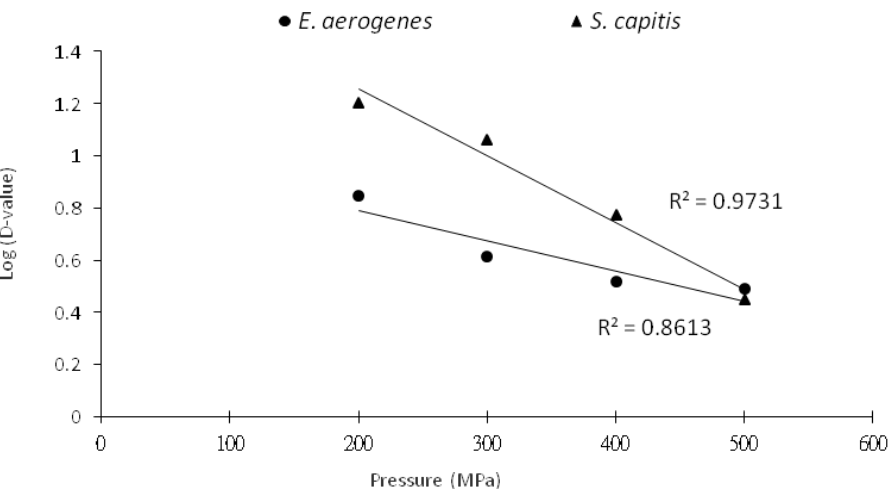
Figure 4. HHP decimal reduction time curves for E. aerogenes and S. capitis in marlin meat slurry.